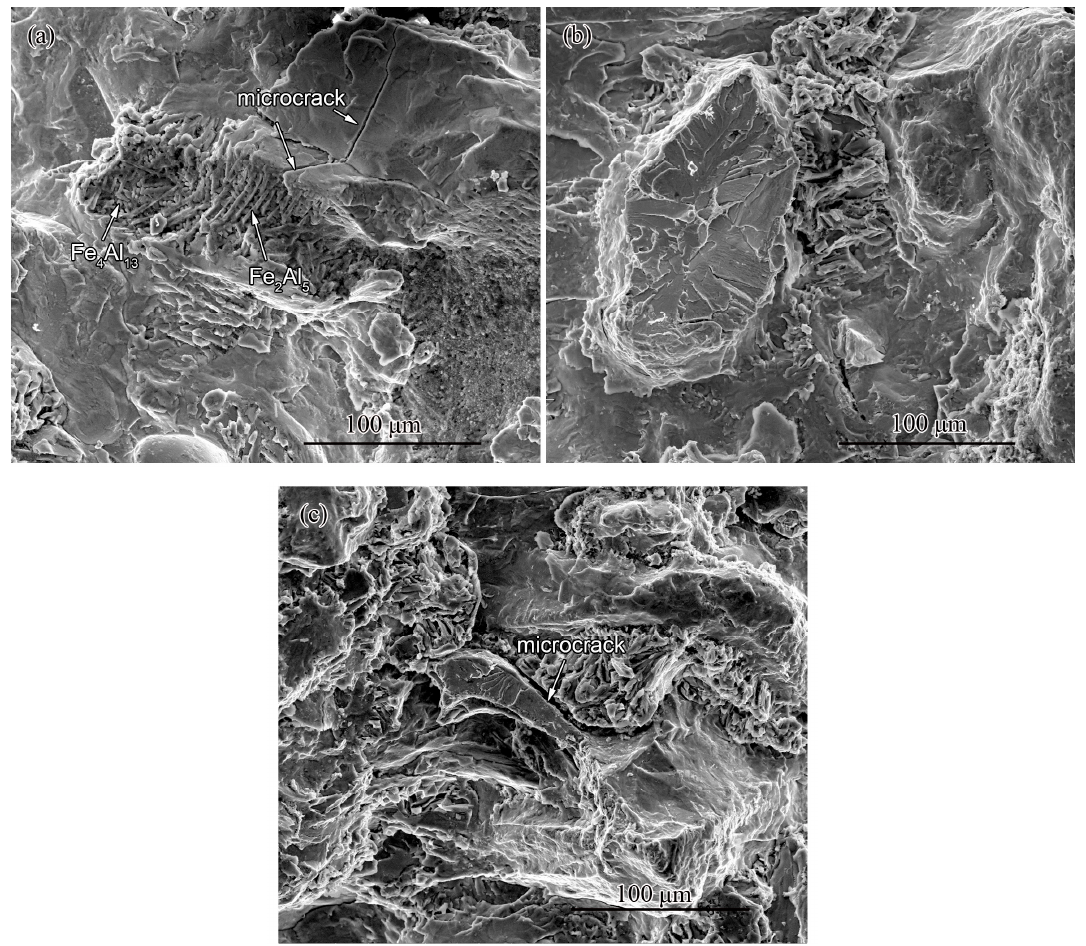
Figure 15. Scanning electronic microscope (SEM) micrographs of the middle position at the interface of the steel/Al alloy butt joint: ( a ) Al alloy side; ( b ) steel side; ( c ) steel side showing some dimples.